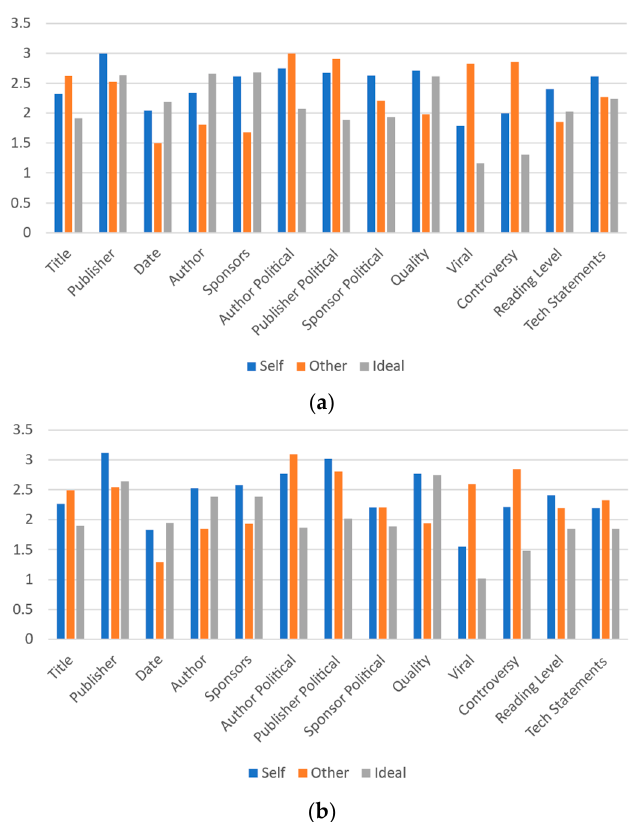
Figure 8. Mean values of participant responses for each article label metric based on values of 0 to 4 where 0 is “none at all” and 4 is “a great deal”: ( a ) University A and ( b ) University B.